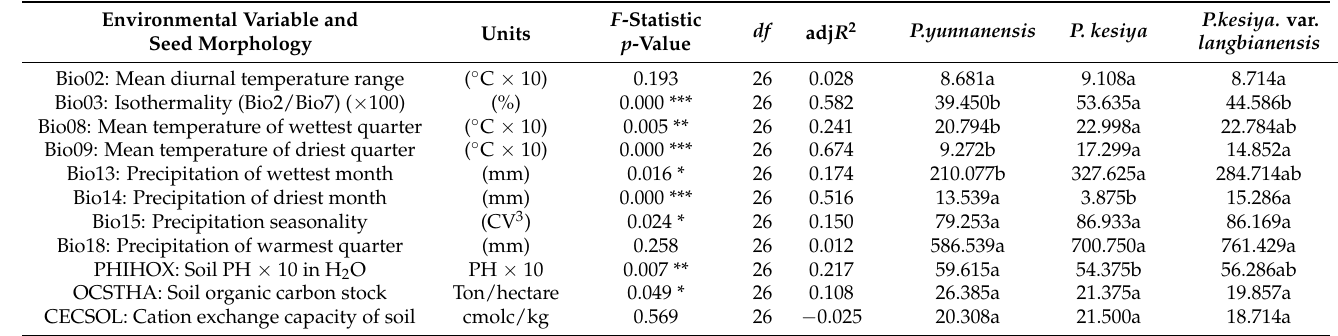
Table 1. Comparison of environmental variables between the P. yunnanensis , P. kesiya, and P. ke- siya var. langbianensis populations. Significant differences are indicated by asterisks (* p < 0.05; ** p < 0.01; *** p < 0.001). Different lowercase letters indicate significant differences (Tukey’s HSD mean separation test).